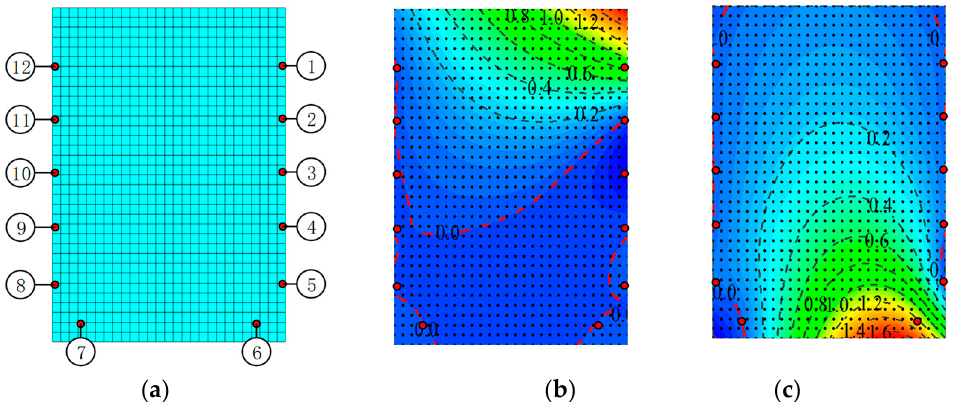
Figure 9. The finite element model of cross-section and profile of numerical shape function: ( a ) finite element model; ( b ) discrete weighting function N 1 ; ( c ) discrete weighting function N 6 .